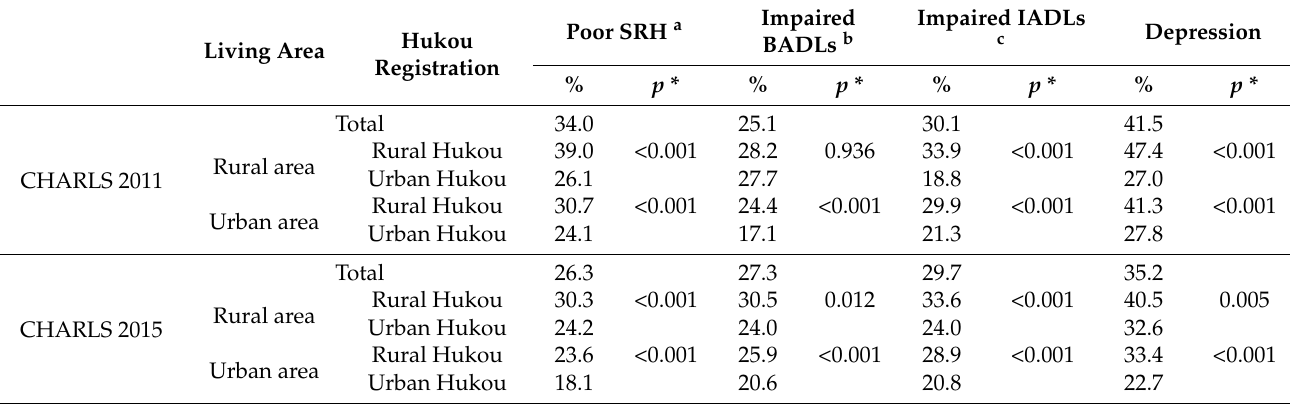
a SRH: Self-Reported Health; b BADLs: Basic Activities of Daily Living; c IADLs: Instrumental Activities of Daily Living; * Chi-square test between respondents with different Hukou registration in rural and urban areas, respectively. The level of significance was specified at